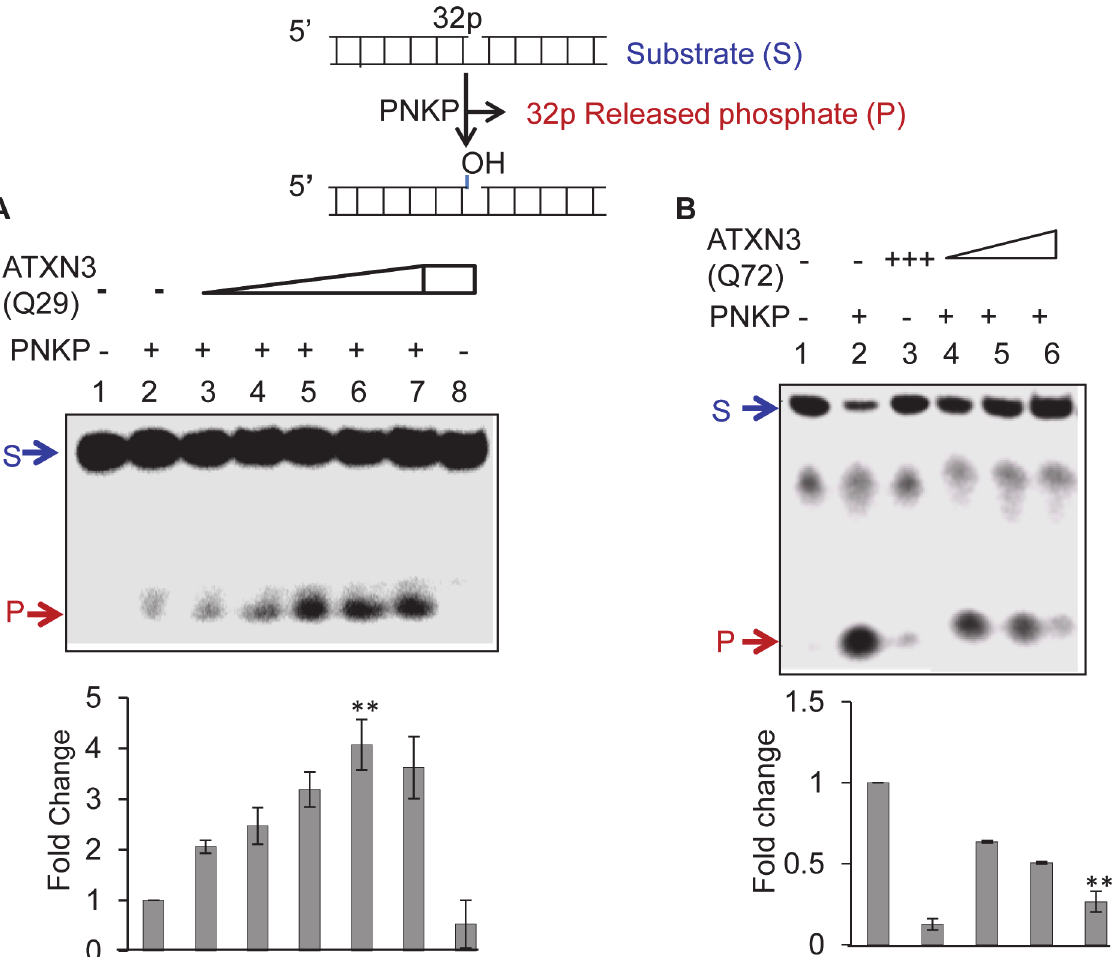
Figure 3. Effect of WT (Q29) or mutant (Q72) ATXN3 on PNKP ’ s 3 ’ -phosphatase activity. (A) A 32 P-labeled 3 ’ -phosphate-containing oligo substrate (5 pmol) was incubated at 37°C for 10 min in buffer A (25 mM Tris-HCl, pH 7.5, 100 mM NaCl, 5 mM MgCl 2 , 1 mM DTT, 10% glycerol and 0.1 μ g/ μ l acetylated BSA) with PNKP alone (50 fmol, ln 2) or ATXN3-Q29 alone (400 fmol, ln 8) or PNKP plus increasing amounts of Q29 (25, 50, 100, 200 and 400 fmol; lns 3 – 7). Ln 1, substrate only. Generation of the 32 P-labelled 3 ’ P-containing oligo substrate was described previously [53]. (B) Effect of mutant ATXN3 (Q72) on PNKP ’ s 3 ’ -phosphatase activity. 32 P-labelled 3 ’ -phosphate-containing oligo substrate (2.5 pmol) was incubated with PNKP at 37°C for 20 min alone (50 fmol, ln 2), ATXN3-Q72 alone (200 fmol, ln 3), PNKP (50 fmol) plus increasing amounts of Q72 (50, 100 and 200 fmol, lns 4 – 6). Ln 1, no protein, substrate only. Quantitation of the products (released phosphate) is represented in the histogram (lower panel), with the activity of PNKP alone arbitrarily set as 1 (n = 3, ** = P < 0.01).